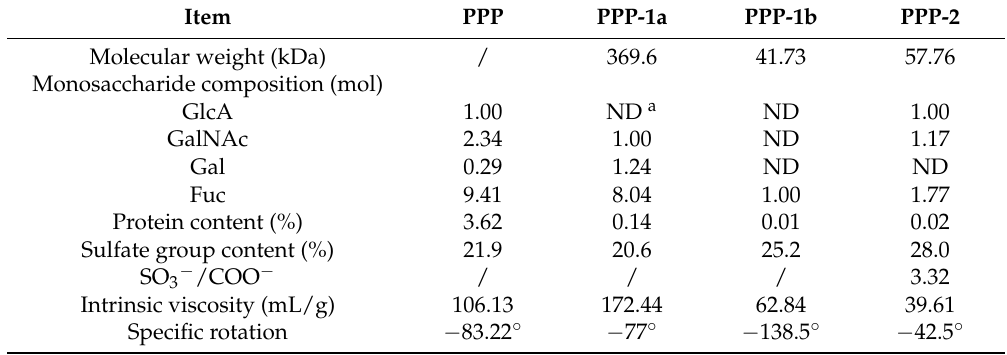
Table 4. Chemical compositions and physicochemical characteristics of PPP, PPP-1a, PPP-1b and